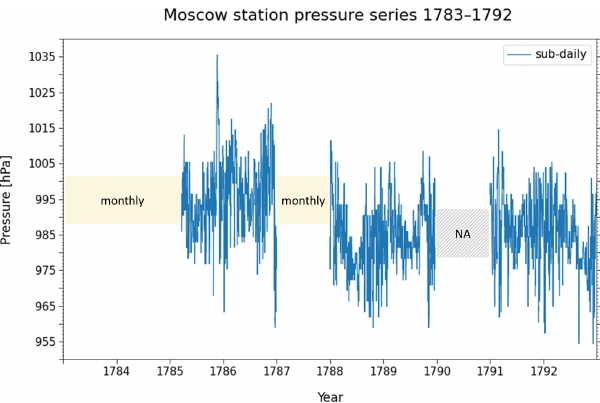
Figure 6. Station pressure series of Moscow for the period from 1783 to 1792. Shown are sub-daily values in hectopascals (blue) and shade areas that represent the availability of monthly data (yellow) or no available data